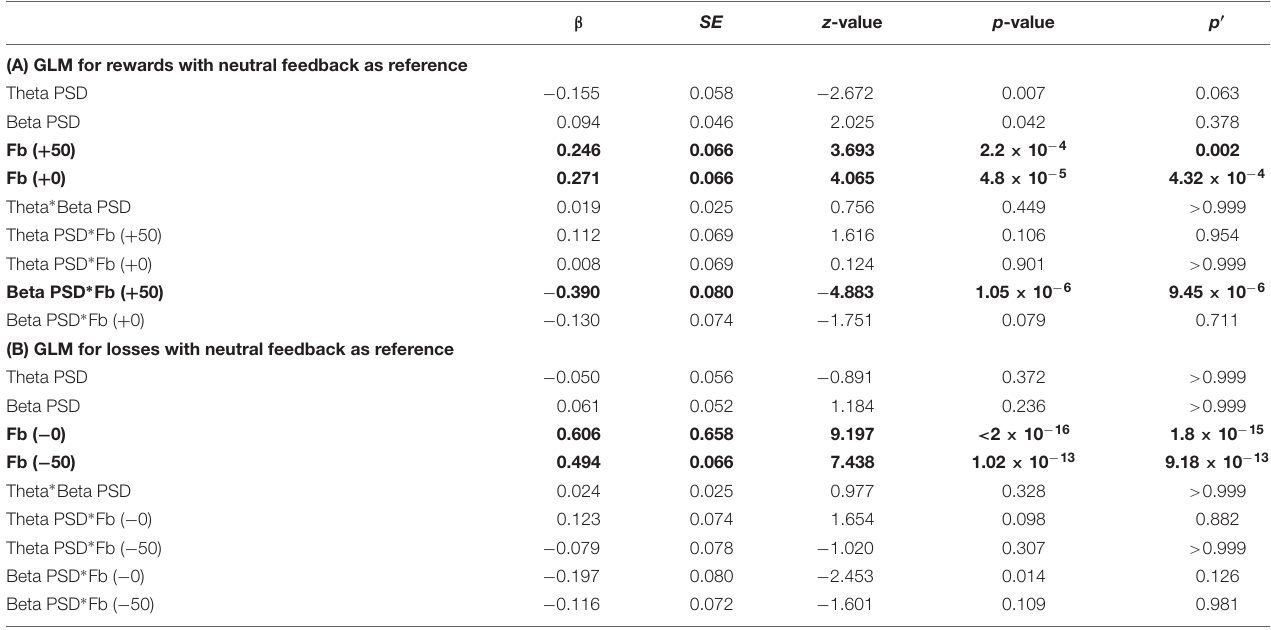
TABLE 1 | Generalized Logistic Model (GLM) predicting risk decision making in the following trial for rewards (A) and losses (B) with neutral feedback as the reference variable. β SE z -value p